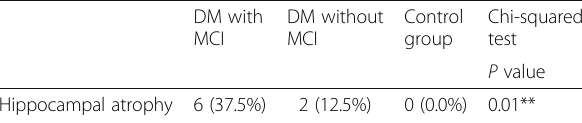
Table 2 The distribution of hippocampal atrophy among the study groups